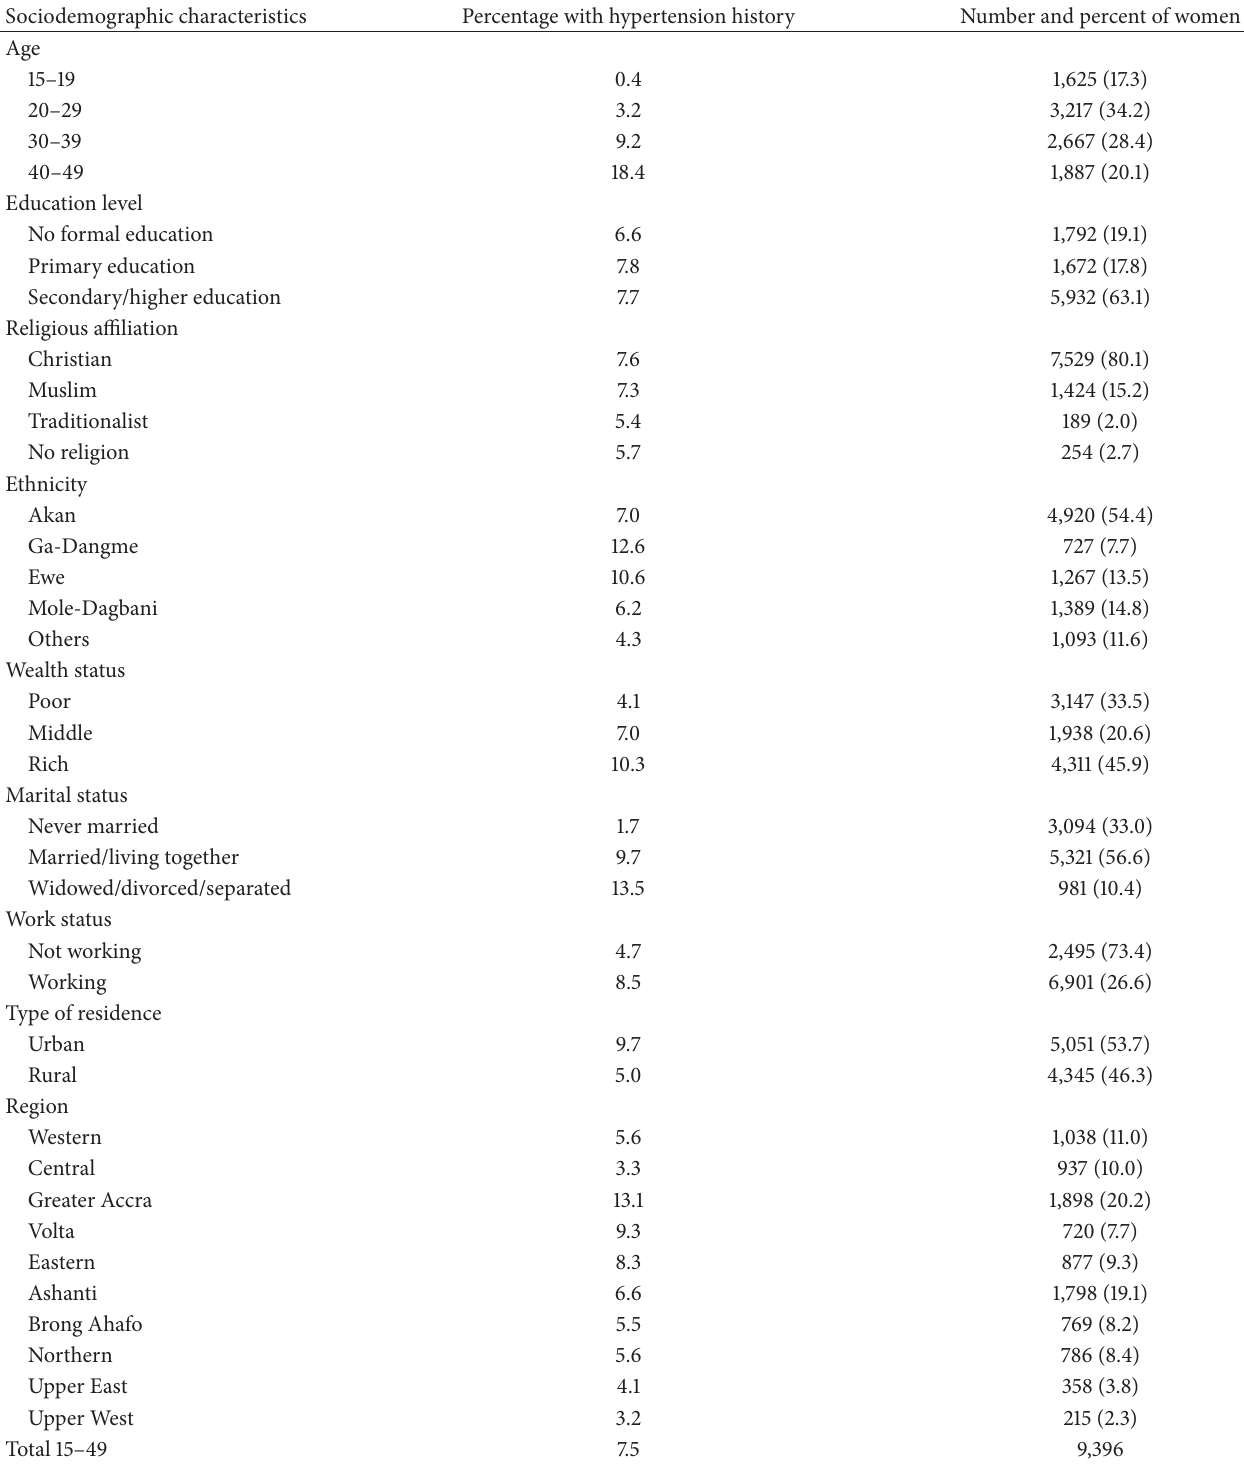
Table 1: Prevalence of hypertension history by sociodemographic